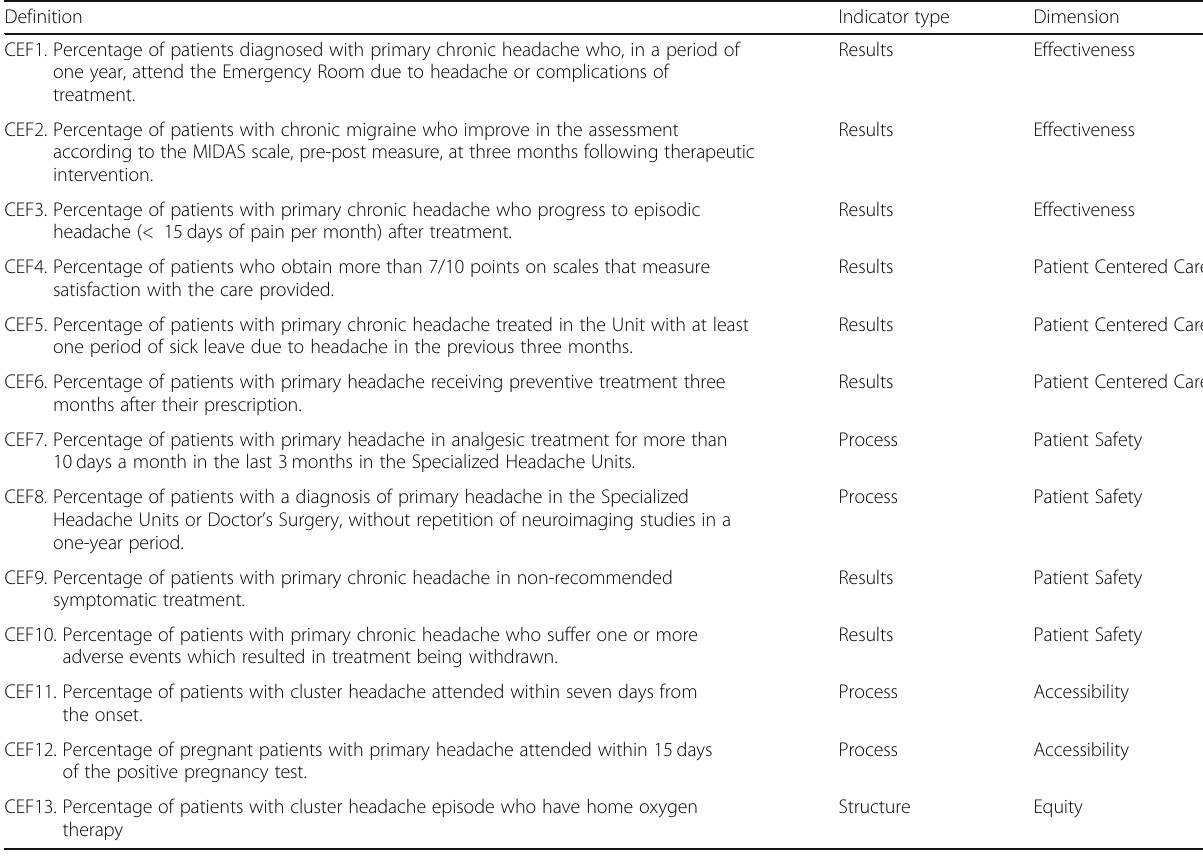
Table 2 Indicators used in this study Definition Indicator type